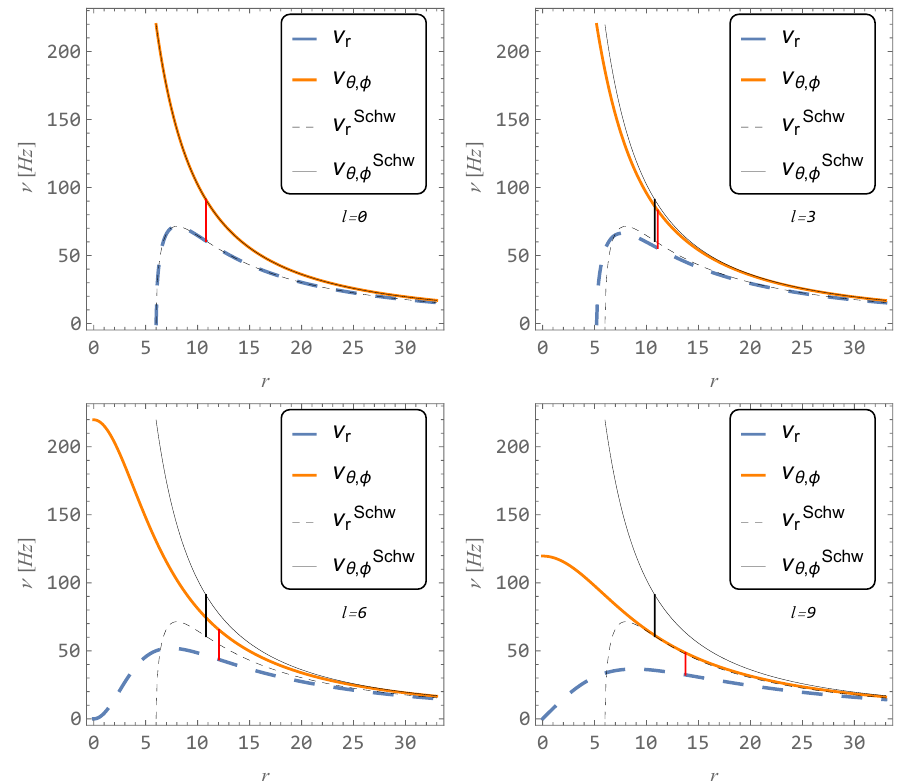
Figure 6. Epicyclic frequencies radial profiles for characteristic values of the parameter l in units of M giving wormholes (except l = 0 corresponding to Schwarzschild black hole) and M = 10 M (cid:12) . Vertical black line indicates frequencies ratio 3:2 for Schwarzschild case and red for given l .